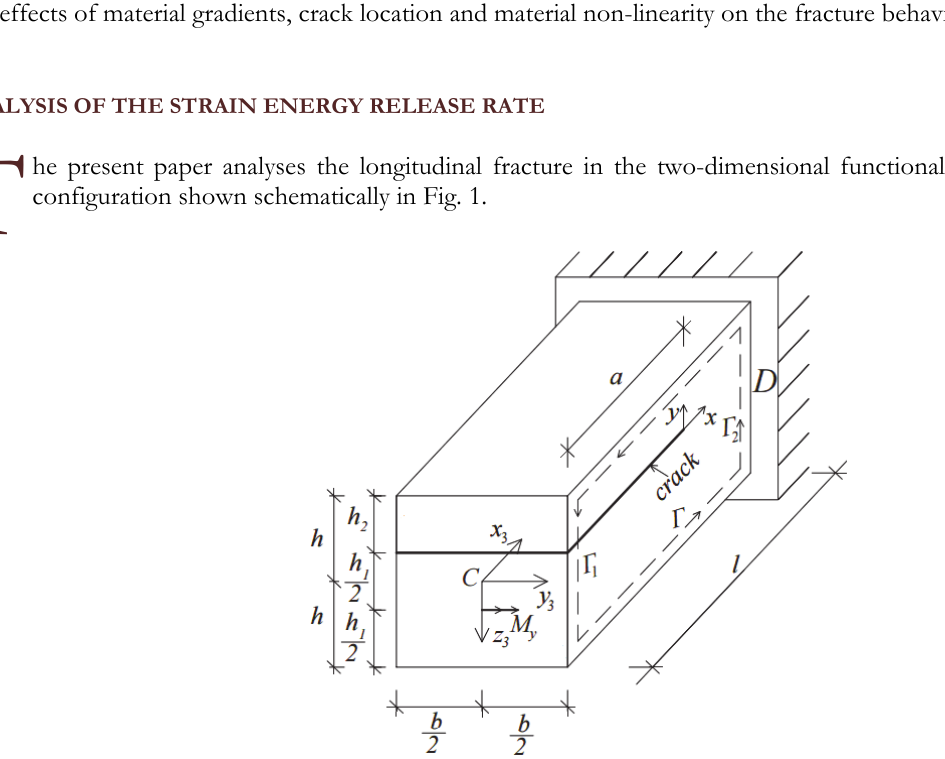
Figure 1: The geometry and loading of the two-dimensional functionally graded cantilever